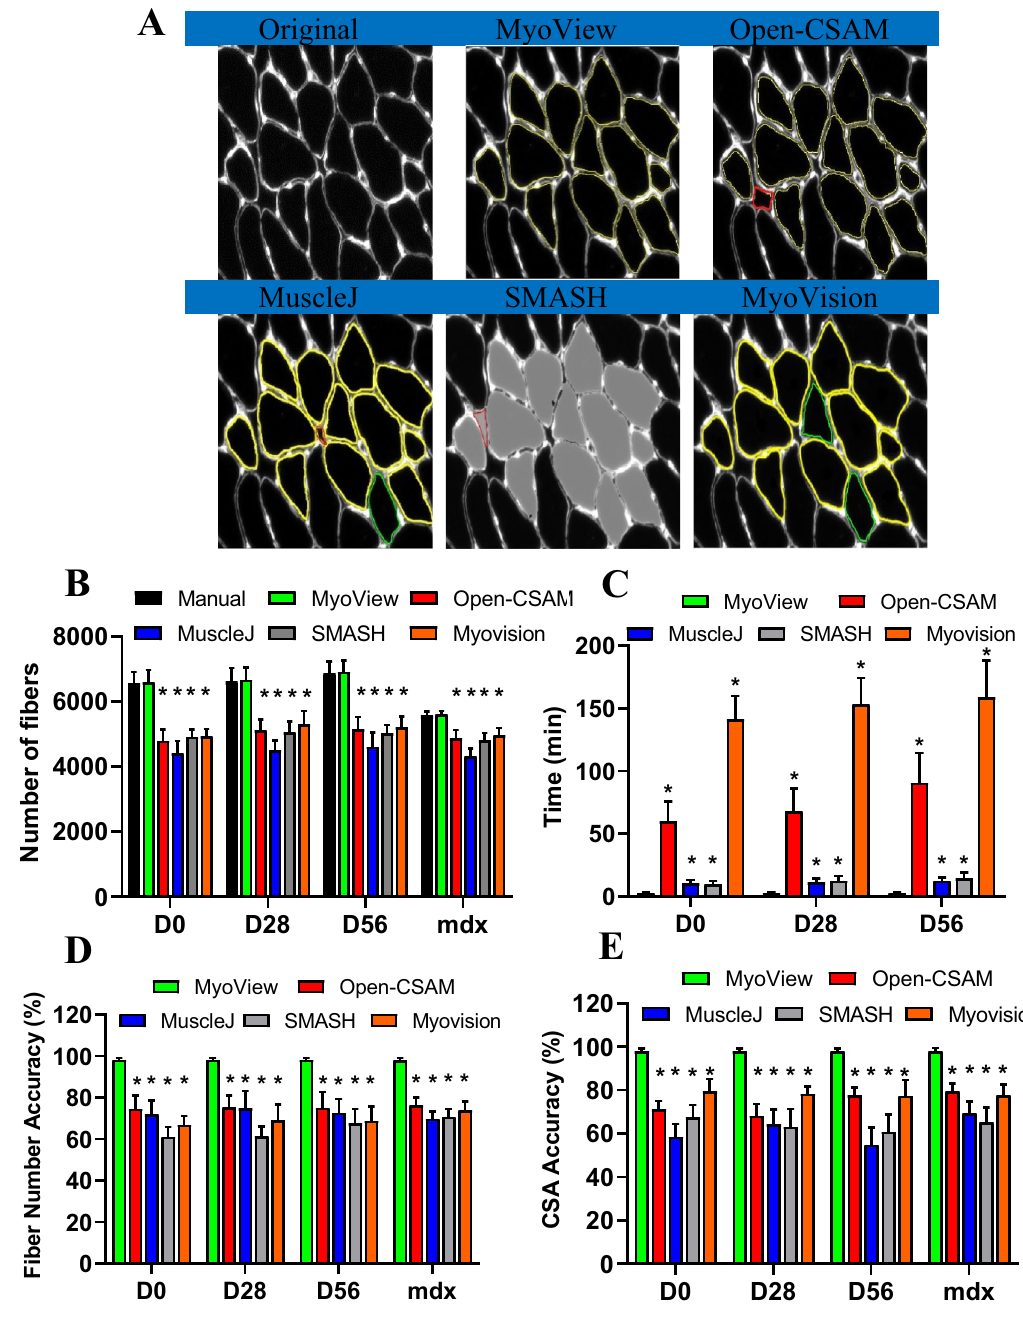
Figure 4. Comparison of MyoView, Open-CSAM, MuscleJ, SMASH, and MyoVision CSA quantification on whole muscle sections. ( A ) Representative images measured by MyoView, Open-CSAM, MuscleJ, SMASH, and MyoVision on gastrocnemius muscle images obtained from 16- to 18-week-old C57BL/6 mice. Segmentation errors are labeled as missed fibers (green), mis-segmented fibers (red). ( B ) Number of fibers identified by the softwares. ( C ) Total analysis time required by the different softwares. ( D ) Fiber number accuracy by the different softwares. ( E ) Mean CSA accuracy by the different softwares. Results are mean ± SEM of 10 images from 5 muscles in each condition. ** P < 0.01 as compared with manual or MyoView